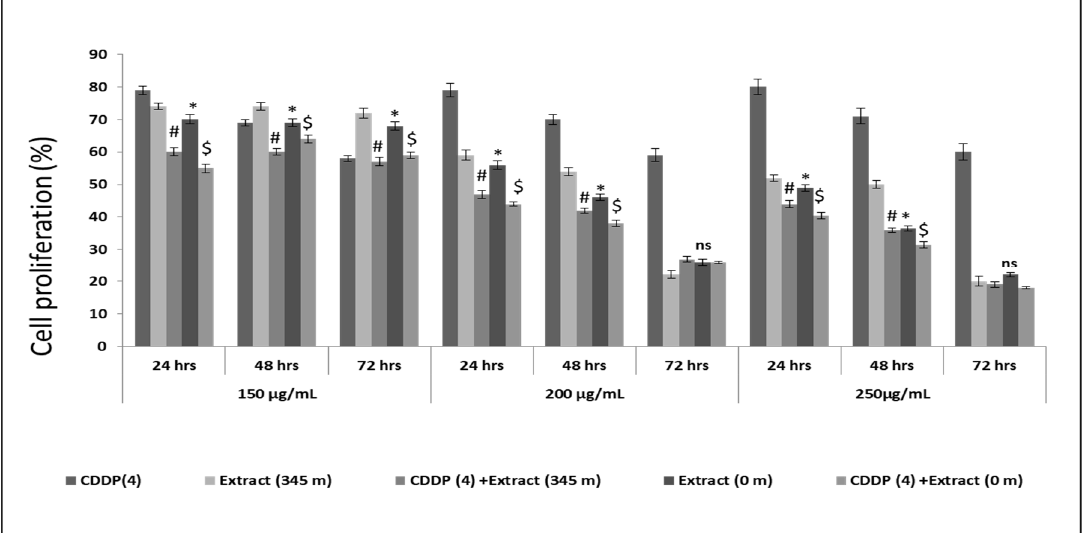
Figure 10. Comparison between the cell proliferation of A549 cells after treatment with CDDP, ethanolic extract, and a combination of both at 24, 48 and 72 h. Peak values are represented as mean +/ − SD. Statistical analysis: Unpaired t test or Mann–Whitney test. * p < 0.05 in which percentage of proliferation of cells treated with 0 m-extract is compared to that of cells treated with 345 m-extract. Statistical analysis: Paired t test or Wilcoxon test # p < 0.05 in which percentage of proliferation of cells treated with a combination of CDDP–extract 345 m is compared to that of cells treated with extract 345 m alone. Paired t test or Wilcoxon test $ p < 0.05 in which percentage of proliferation of cells treated with a combination of CDDP–extract 345 m is compared to that of cells treated with extract 345 m alone. ns refers to non-significant results.